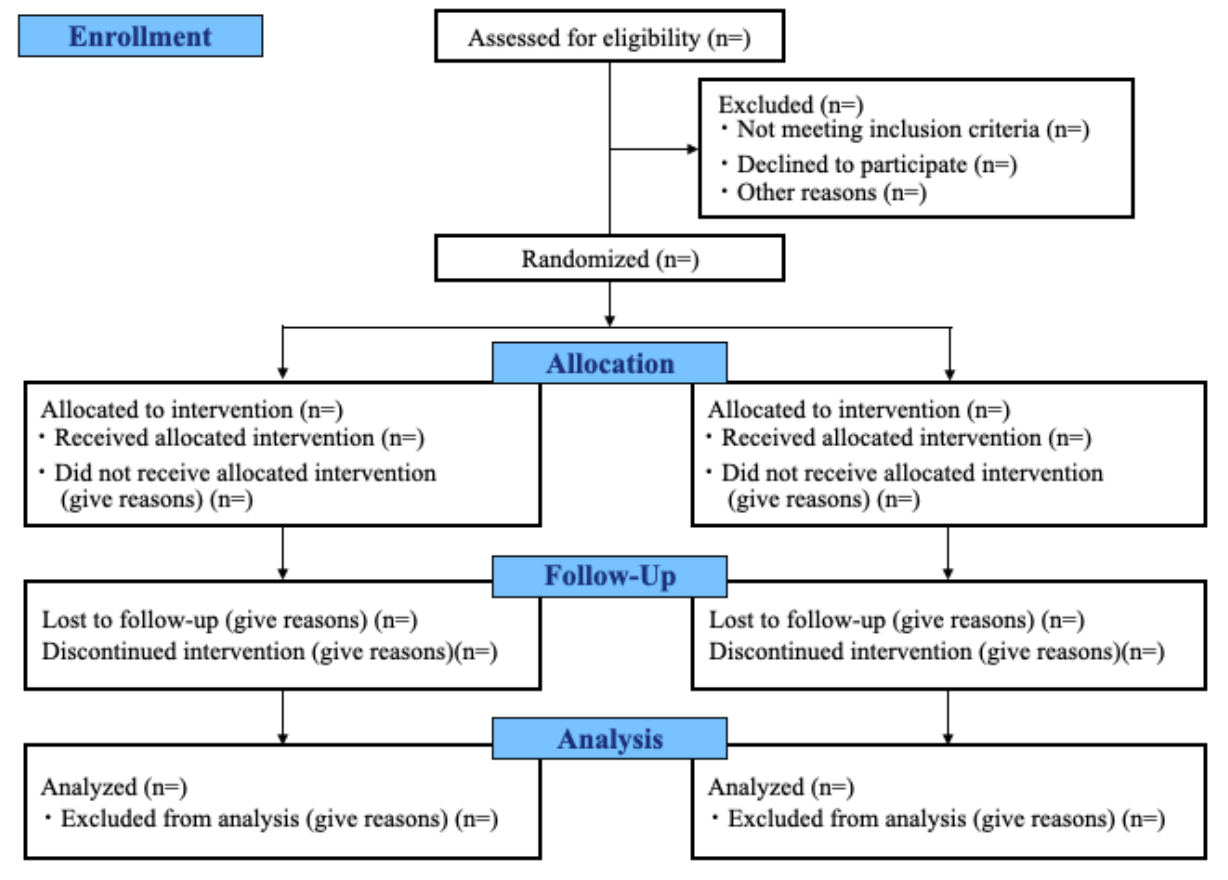
Figure 1. CONSORT flow diagram of a parallel randomized trial with two